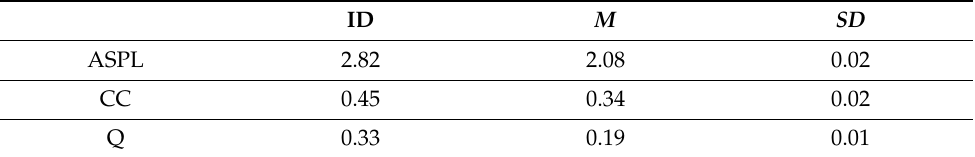
Table A3. Random Network comparison for the network of the adolescents with ID (dataset 2), p < 0.001 for all comparisons.